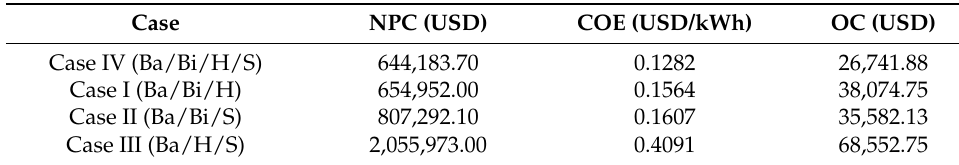
Table 3. Comparative economical indicators for cases I to IV.